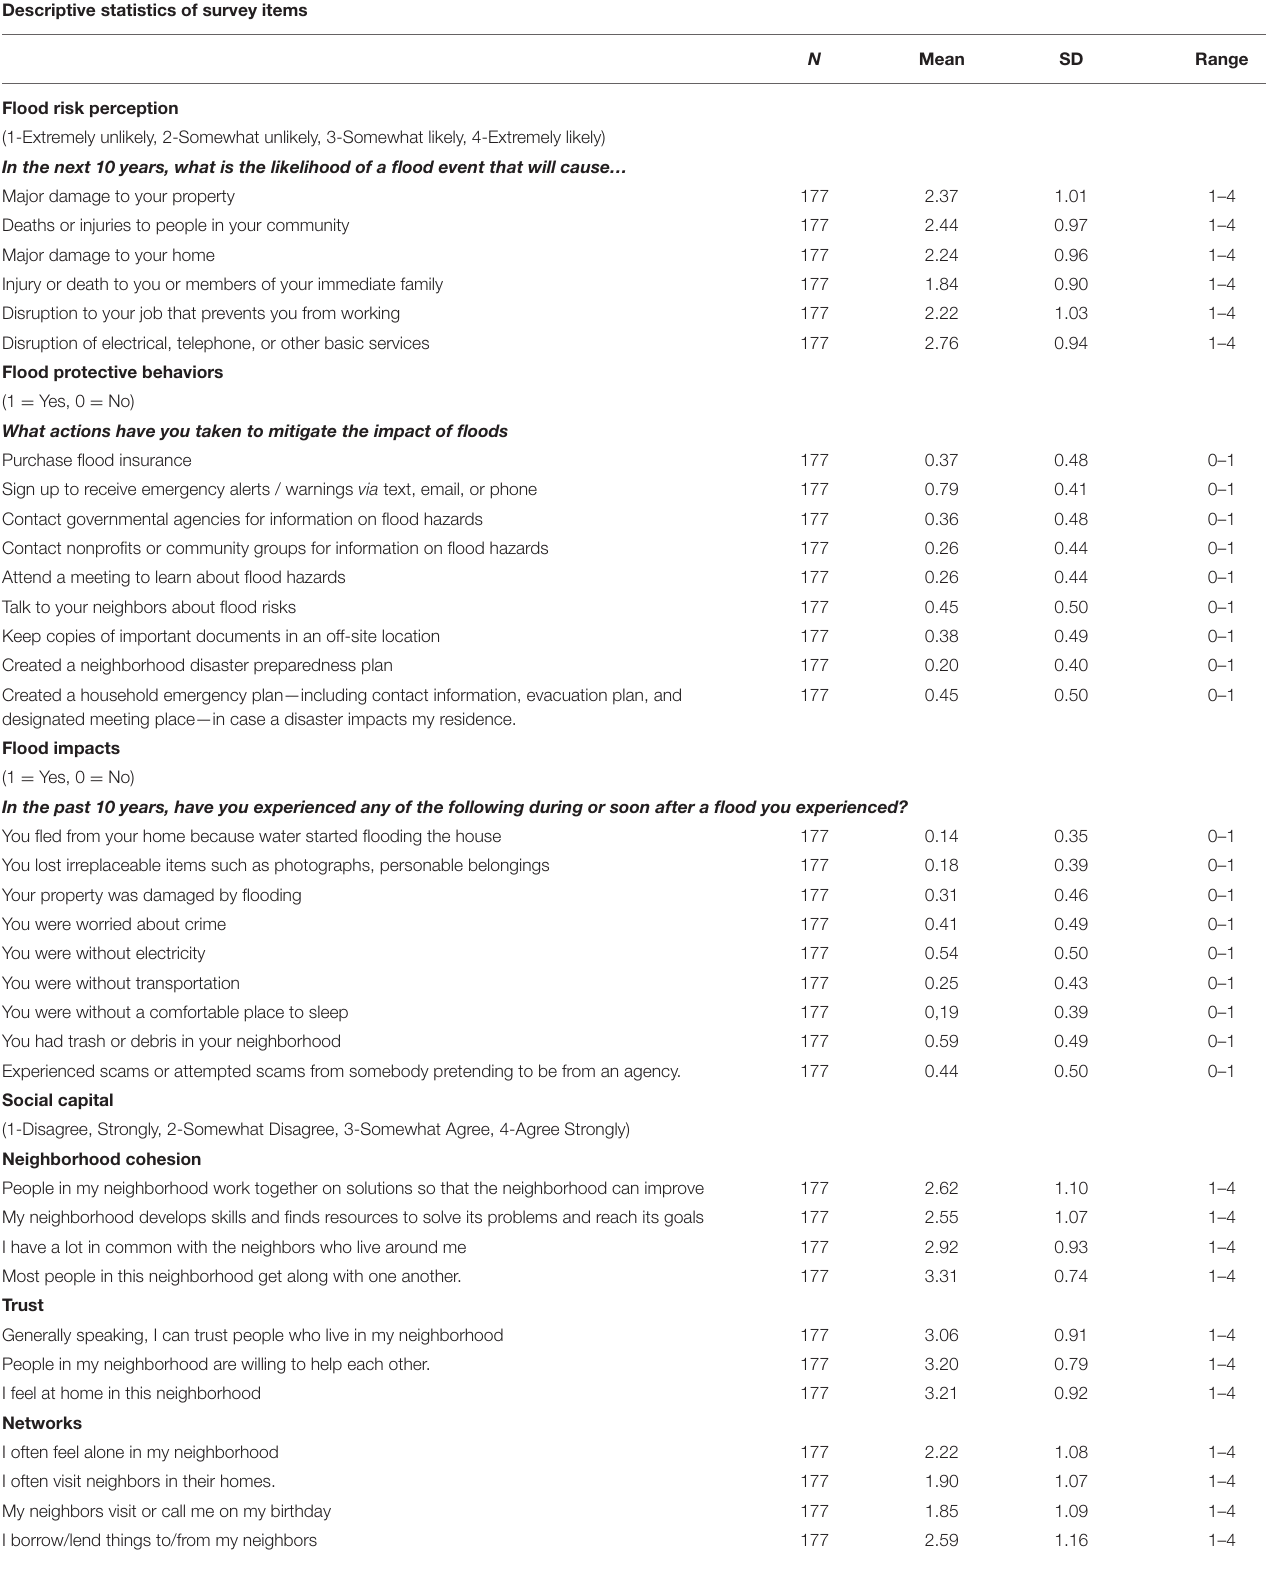
TABLE 2 | Descriptive statistics of survey